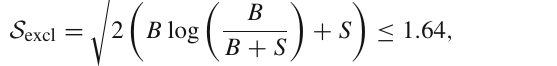
fb − 1 (dashed red line). Dashed vertical lines indicate the mass region for each analysis, see Table 2. The gray area is disfavored at 95% CL by theATLASsimilarsearchforLFVhigh-massfinalstatesinthe (cid:2) ν → τμ channel at L = 36.1 fb − 1